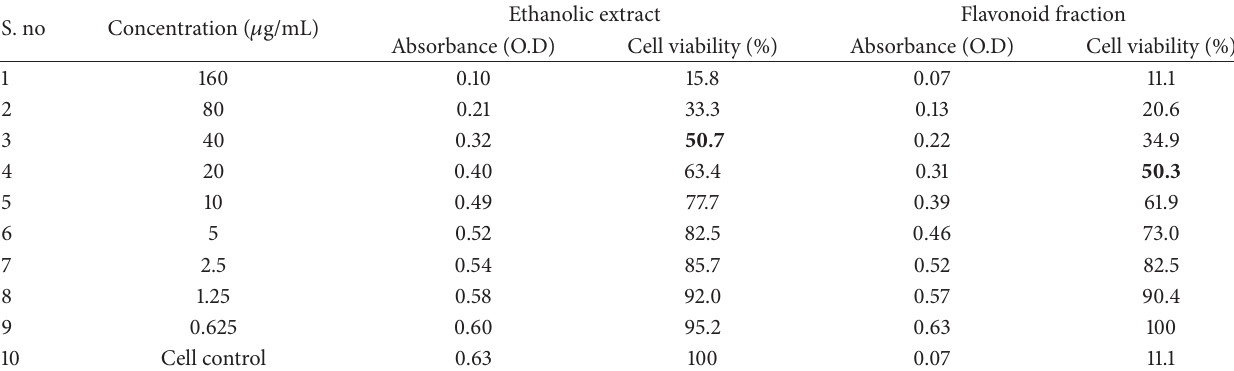
Table 3: Anticancer effect of ethanolic extract and flavonoid fraction on MCF7 cell line. S.